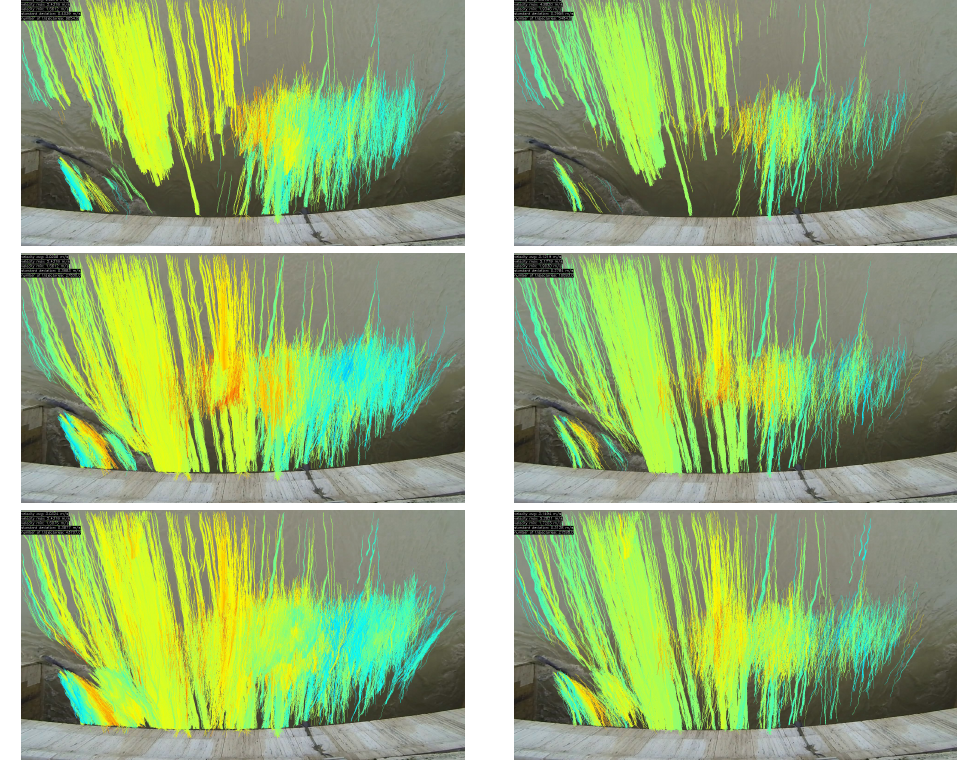
Figure 9. Comparison between the original OTV algorithm, on the left, and its optimized counterpart obtained by the functional analysis, on the right, on three frames (100, 200 and 300) of the 33-s sequence acquired on the Tevere river in